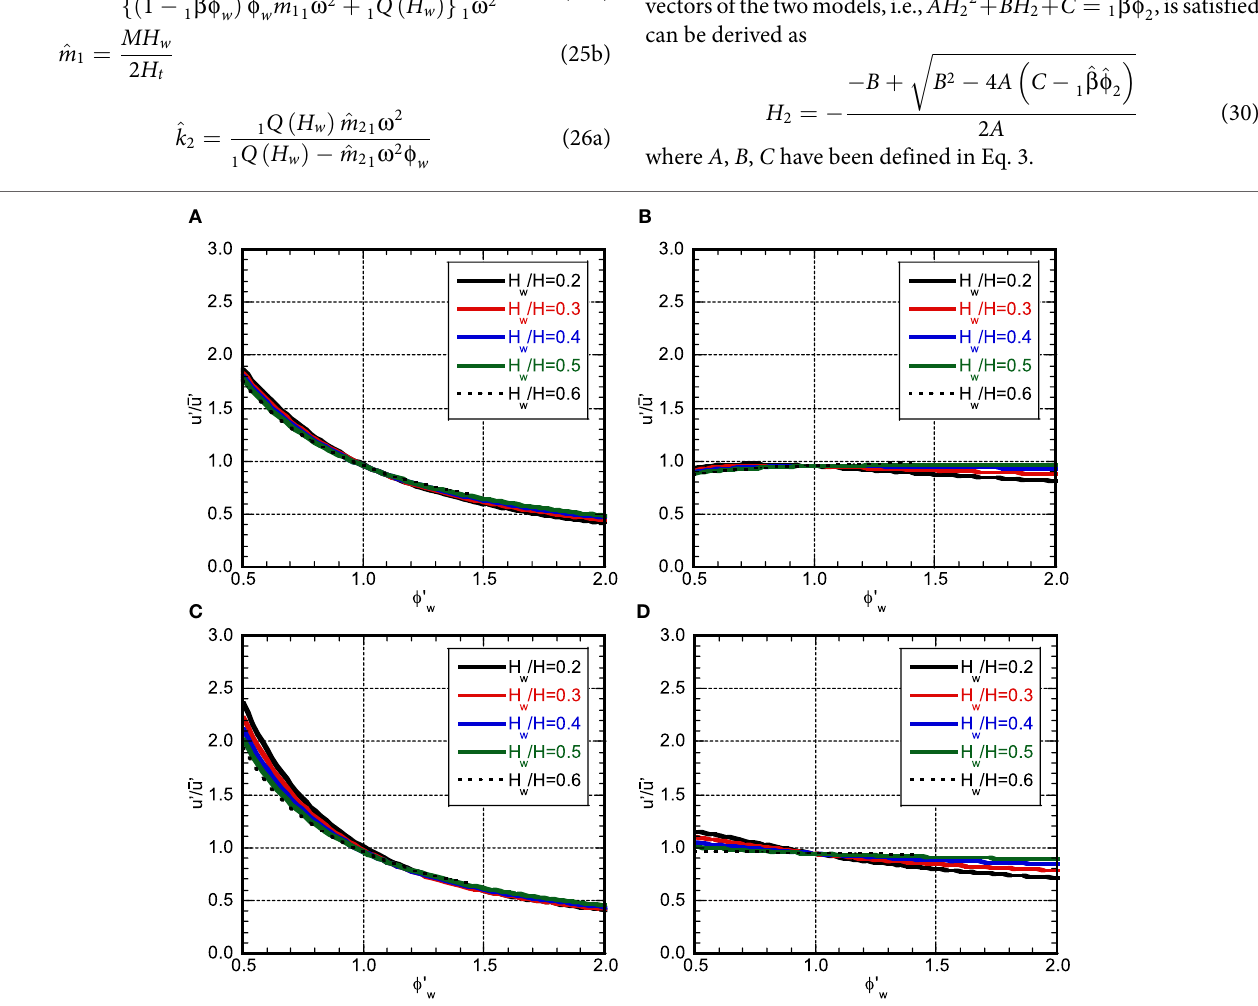
FIGURE 13 | Maximum story drift angle ratio (variable: H w / H ): (A) upper structure (D 2% ), (B) lower structure (D 2% ), (C) upper structure (D 5% ), and (D) lower structure (D 5% ).